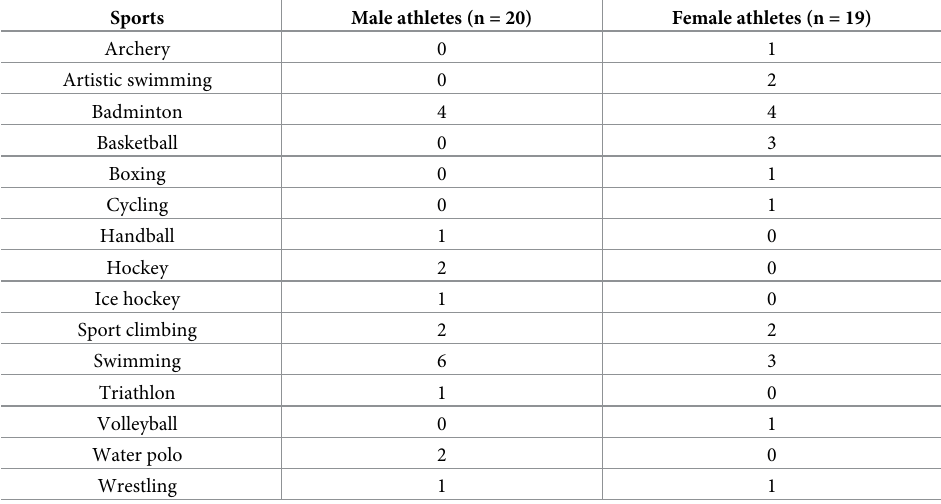
Table 1. Sporting disciplines of